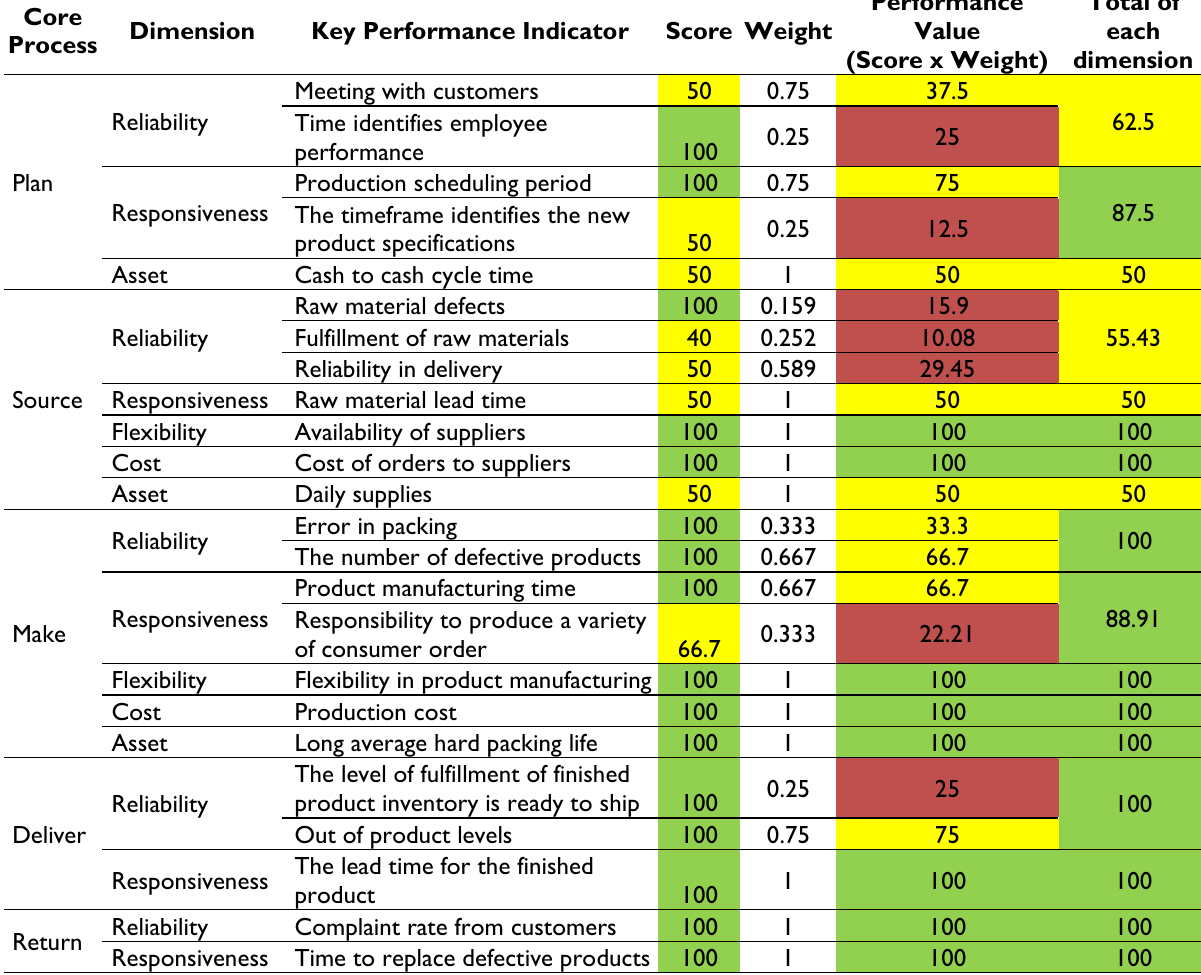
Table 11: KPI Final Score Calculation Core